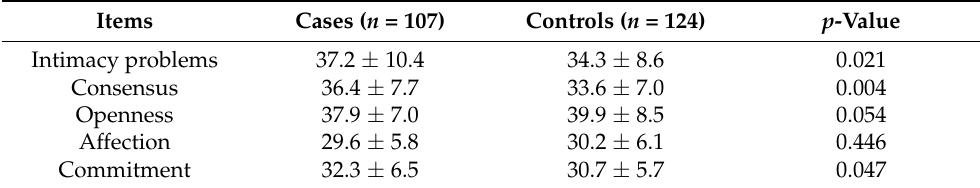
Table 6. Comparison of MIQ survey results between cases and controls.